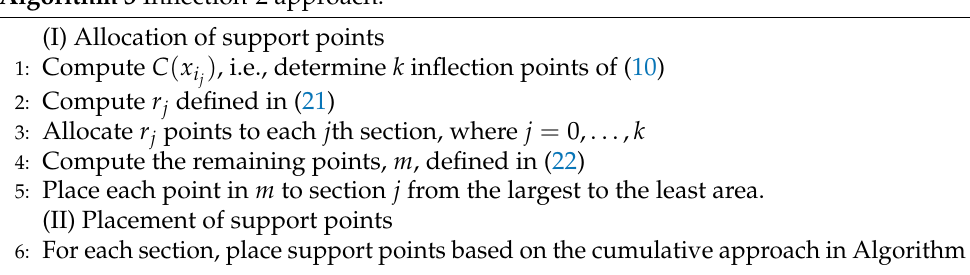
Algorithm 3 Inflection-2